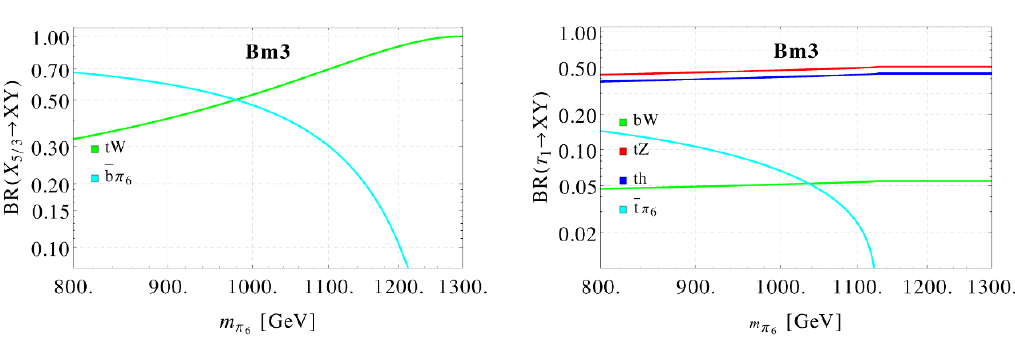
and the lightest T 1 as a function of m (cid:25) 5 = 3